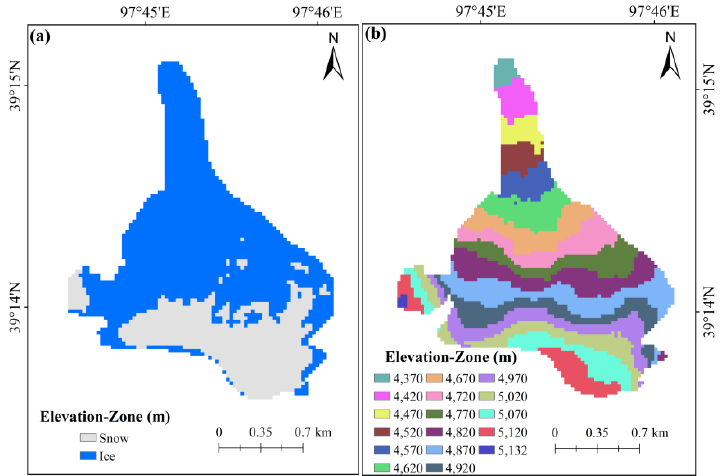
Figure 2. Classification results of Landsat images of Qiyi Glacier in Qilian Mountains by maximum likelihood method (Landsat images of 2013, LC0820130820) ( a ), and height zones of DEM images reclassified at 50 m intervals ( b ). Table 4. Threshold for determining the position of the snow line and SLA of Qiyi Glacier in the Qilian Mountains during the 1989–2018 period.